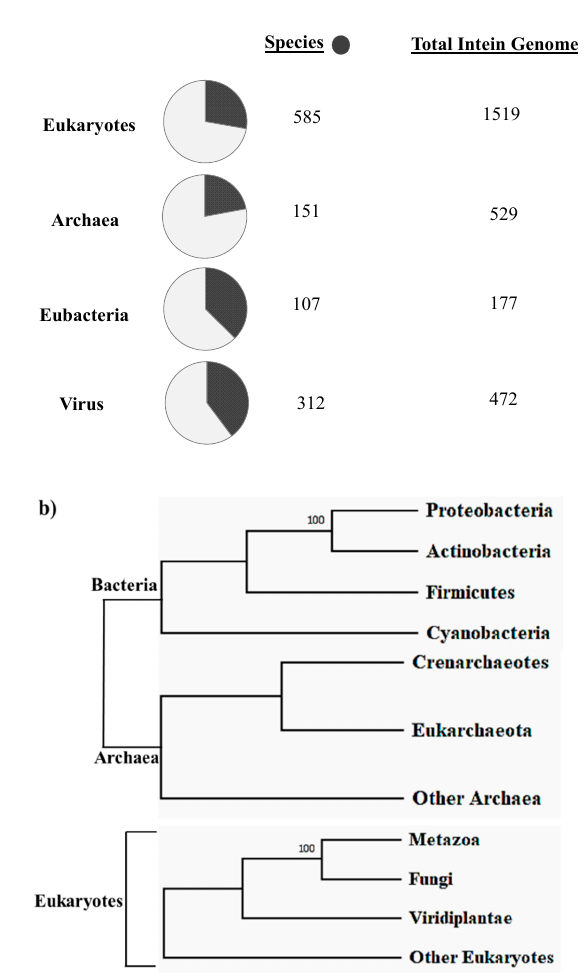
Figure 2. Sporadic distribution of inteins. ( a ) Summary of intein distribution with the total number of intein-containing genome from respective species indicated. The intein distribution data were extracted from the NCBI Gene data base. ( b ) Schematic representation of the tree of life showing four phyla for bacteria, three phyla for archaea and three kingdoms of eukarya (Metazoa, Fungi and Viridiplantae). All other eukaryotes are shown with the basal branch. Intein-containing gene sequences were obtained from NCBI and analyzed by MEGA-X software. The phylogenetic tree was constructed using the neighbor-joining